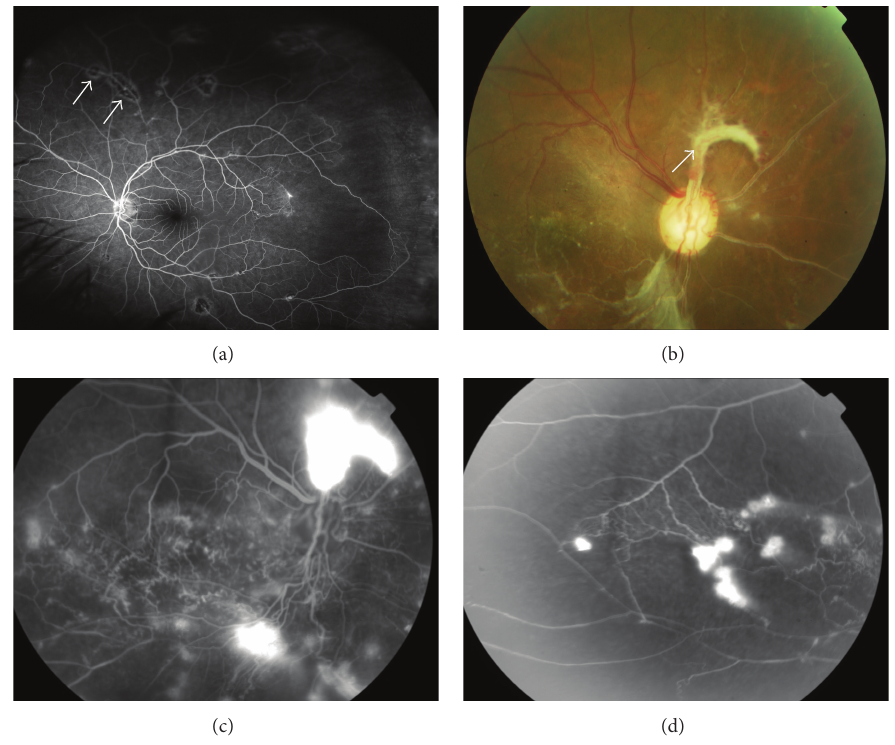
Figure 2: Fundus images of presumed tuberculous occlusive vasculitis. (a) Fundus fluorescein angiography shows peripheral retinal nonperfusion together with small area of hypofluorescence corresponding to chorioretinal lesions along the retinal blood vessels (arrow). (b) A color image showing vascular sheathing together with a fibrovascular tuft originating from the optic disc (arrow), with fluorescein angiography showing (c) leakage at the disc and (d) peripheral capillary dropout and dye leakage from new vessels